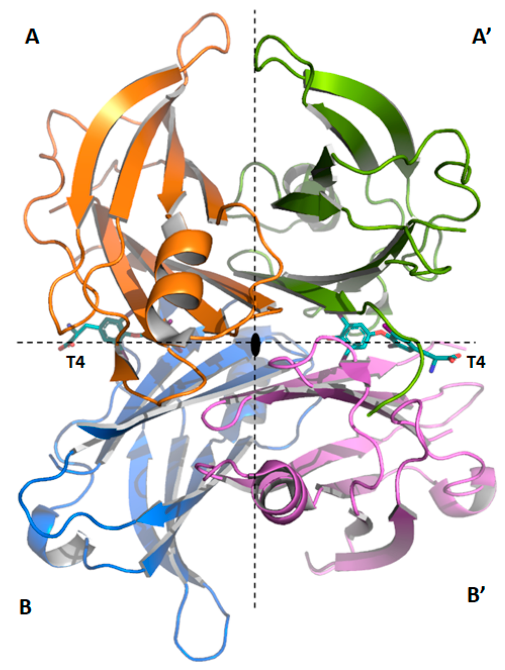
Figure 1. Graphic representation of TTR tetramer in complex with T4 (pdb structure 1sn0). The